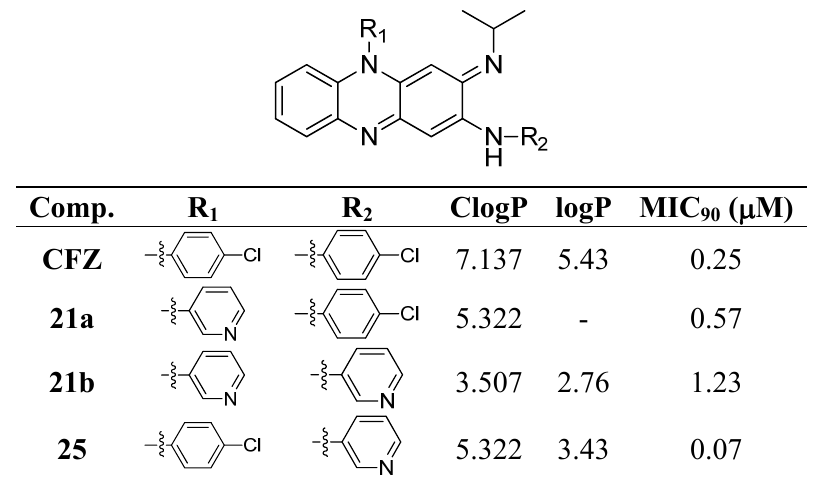
and R variation and their anti-tuberculosis activity 1 3 Rv, physicochemical property (log 37